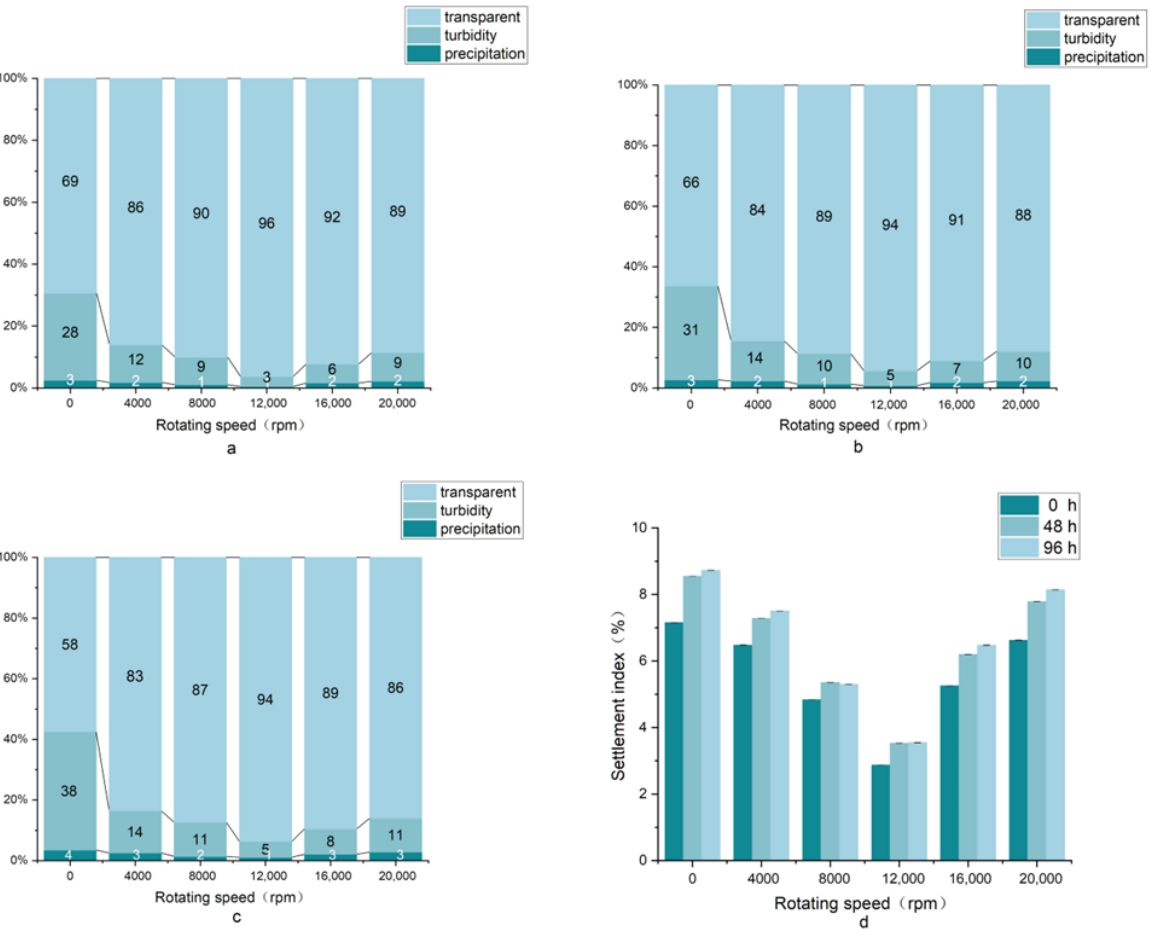
Figure 4. Proportion (%) of turbidity, transparency, and precipitation in CLB samples. ( a ): 0 h; ( b ): 48 h; ( c ): 96 h; ( d ): sedimentation index.